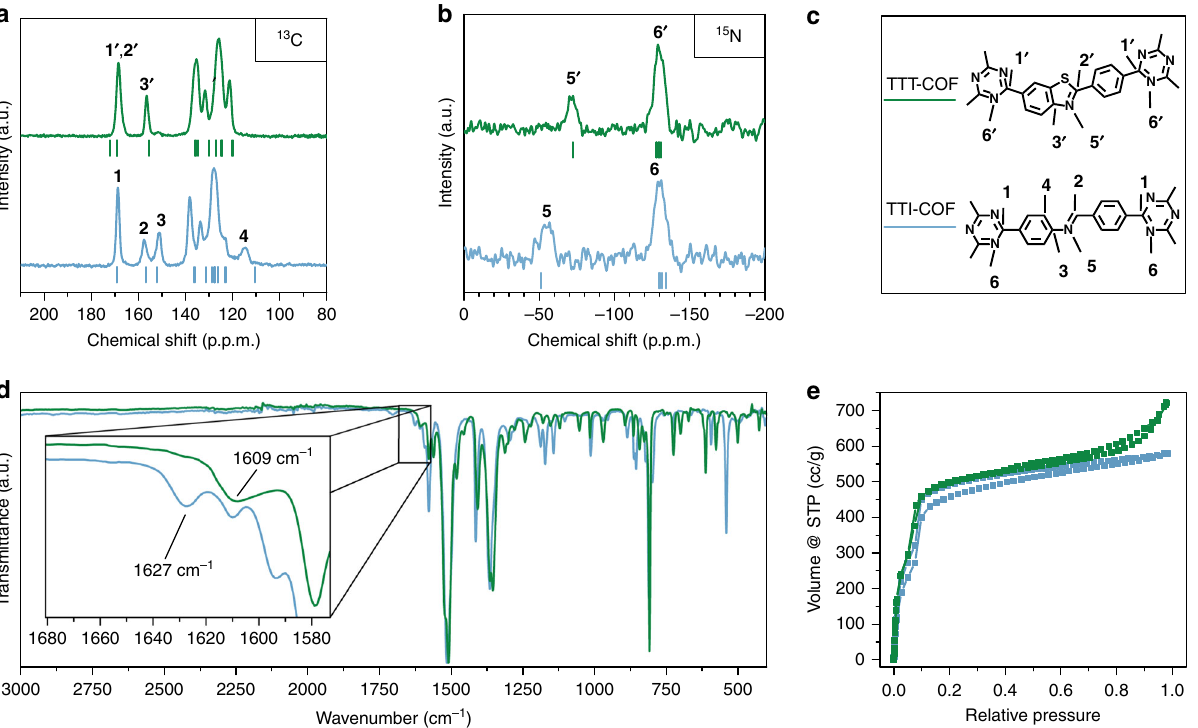
Fig. 2 Characterization of the TTI-COF (blue) and TTT-COF (green). a 13 C ssNMR demonstrating the conversion of the imine linkage to the corresponding thiazole. b 15 N ssNMR showing a shift in the imine nitrogen position ( 5 → 5 ′ ). Calculated Δδ values for the TTT and TTI-COF on B97-2/pcS-2 level of theory are shown as red and black dashes, respectively. c Assignment of the 13 C and the 15 N ssNMR signals to the respective 13 C and 15 N nuclei in the structures. d FT-IR spectra of TTI-COF (black) and TTT-COF (red). The inset shows an enlargement of the region characteristic for N = C vibrations. e Argon sorption isotherms of TTI-COF and TTT-COF showing retention of